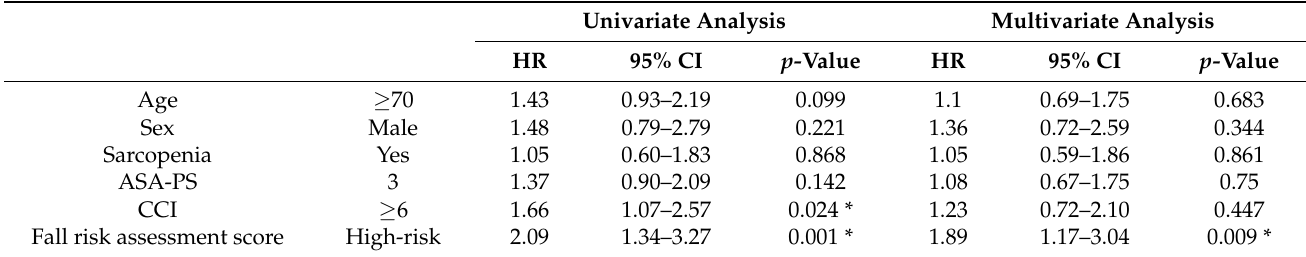
Table 4. Prognostic factors for the relapse-free survival.